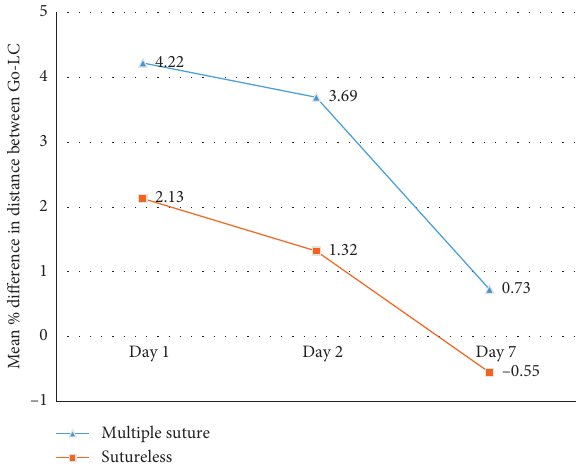
Figure 2: Comparison of swelling (gonion to lateral canthus) between group 1 (multiple sutures) and group 2 (sutureless) on patients undergoing third molar surgery.